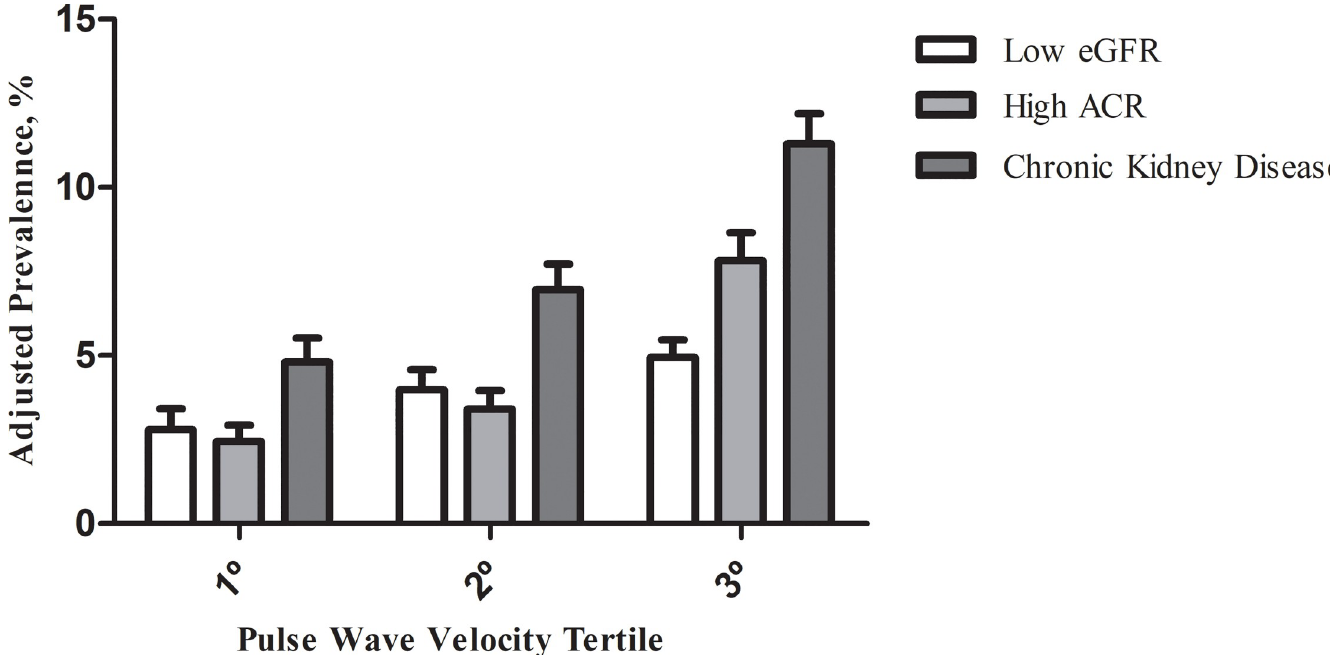
Fig 1. Prevalence of low estimated glomerular filtration rate (eGFR), elevated serum albumin/creatinine ratio (ACR), and chronic kidney disease according to tertile of pulse wave velocity adjusted by age, sex and race/color, and 95% confidence interval in the general population (ELSA-Brasil, 2008–2010).